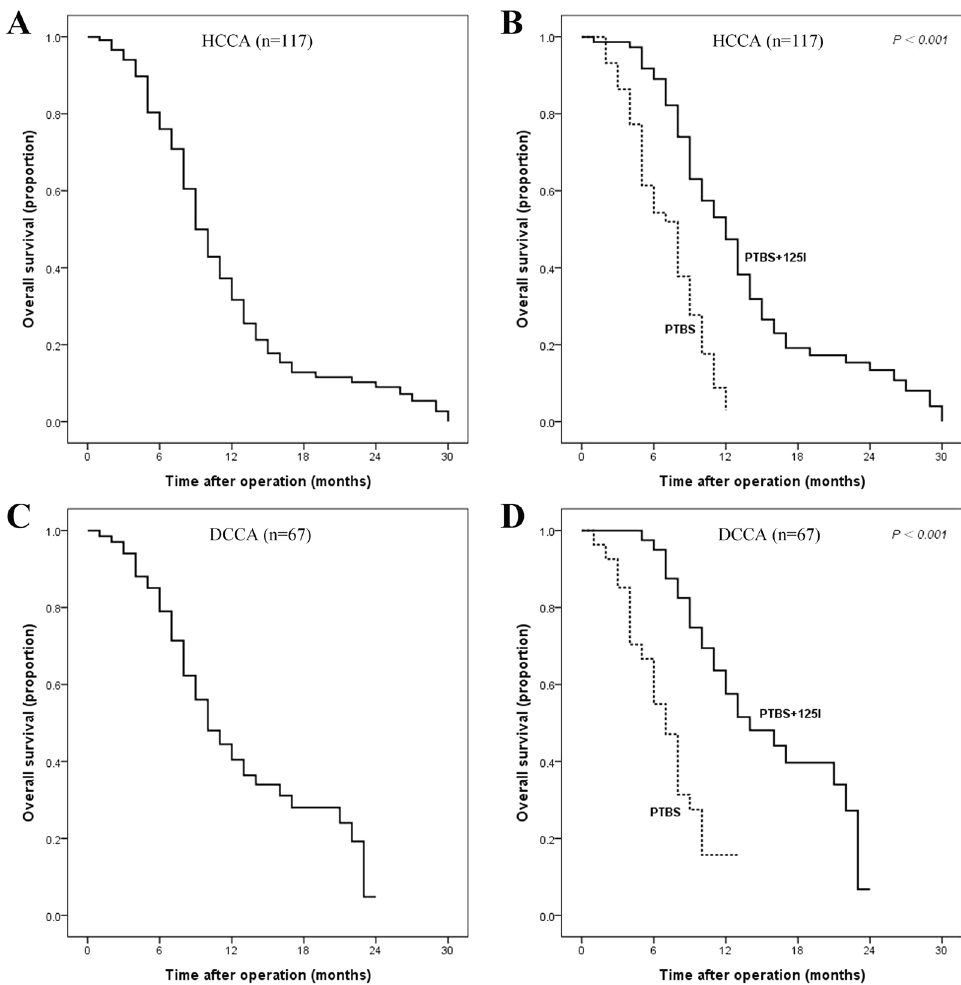
Figure 3. The survival curves of advanced HCCA and DCCA patients. Overall survival curves for HCCA patients ( A ) and stratified according to treatment method in HCCA ( B ); Overall survival curves for DCCA patients ( C ) and stratified according to treatment method in DCCA ( D